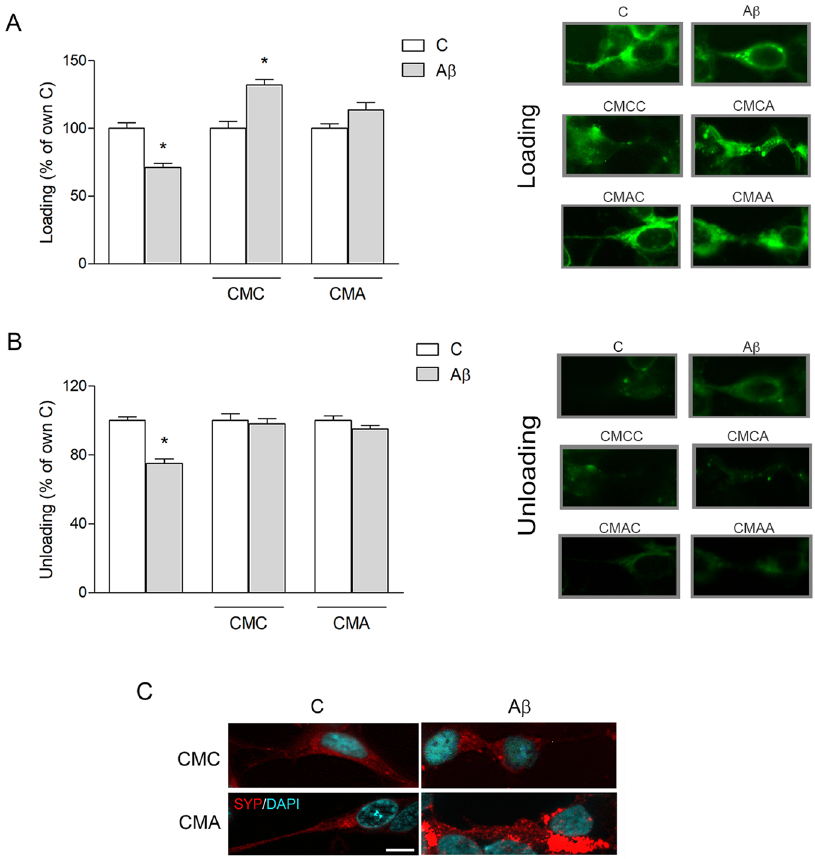
Figure 5. CM from microglia restores synaptic activity impaired following A β 42 exposure. SH-SY5Y cells were treated for 5 h with A β 42 (0.5 μ M) in non-conditioned medium or in CM from untreated (CMC) or A β - treated (CMA) pMG. Cells were stained with FM 1–43 dye and treated to allow formation of labeled synaptic vesicles (loading). Fluorescence intensity was evaluated at the end of the loading step ( A ) and after unloading of fluorescent vesicles by stimulation of exocytosis ( B ). Representative images of cells stained with FM 1–43 in each condition, in the loading and unloading step, are reported next to corresponding graphs. Immunostaining of SYP (red) in SH-SY5Y cells exposed to A β 42 (0.5 μ M) for 5 h in CMA ( C ). Nuclei are stained with DAPI (blue). Values are mean ± SEM with n = 3–5. Scale bar is 10 μ m. * p < 0.05 vs. respective controls by one-way ANOVA followed by Newman-Keuls test for